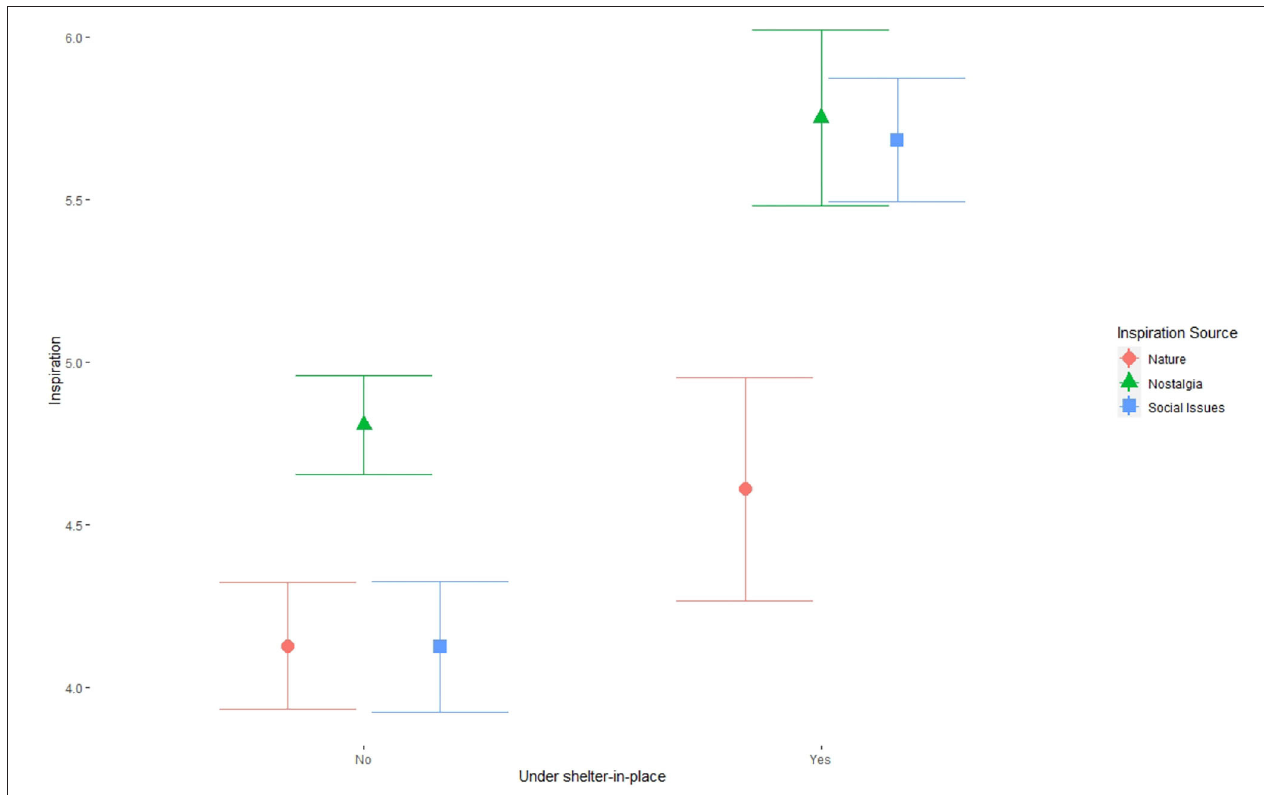
FIGURE 2 | The effect of shelter-in-place orders on inspiration variables, showing mean and 95% confidence intervals. All variables were measured using 7-point Likert scales and lower values indicate a weaker fit between the variable and the music participants made.